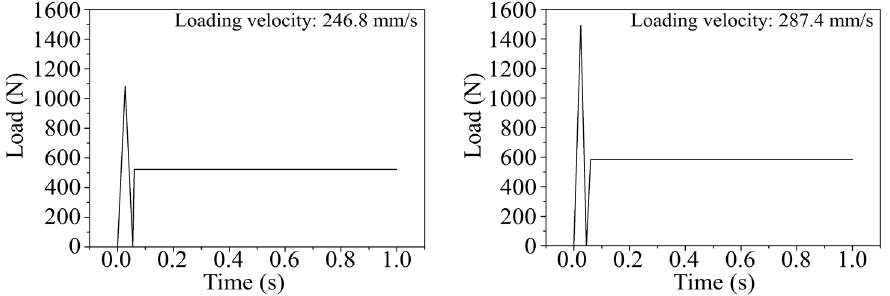
Figure 8. Reconstructed load curves.